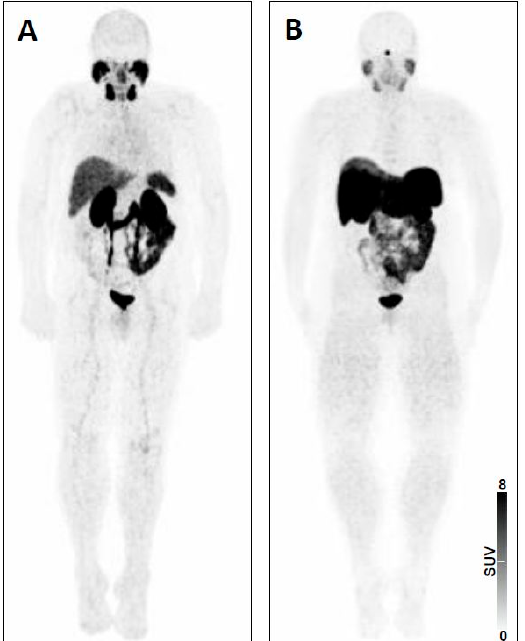
Figure 3. Whole-body maximum intensity projection images with normal biodistribution of ( A ) prostate-specific membrane antigen (PSMA)-targeted positron emission tomography (PET) using 68 Ga-PSMA-11 and ( B ) somatostatin receptor (SSTR)-targeted PET using 68 Ga-labeled 1,4,7,10- tetraazacyclododecane-N,N ′ ,N ′′ ,N ′′′ -tetraacetic acid- D -Phe(1)-Tyr(3)- octreotate ( 68 Ga-DOTATATE).